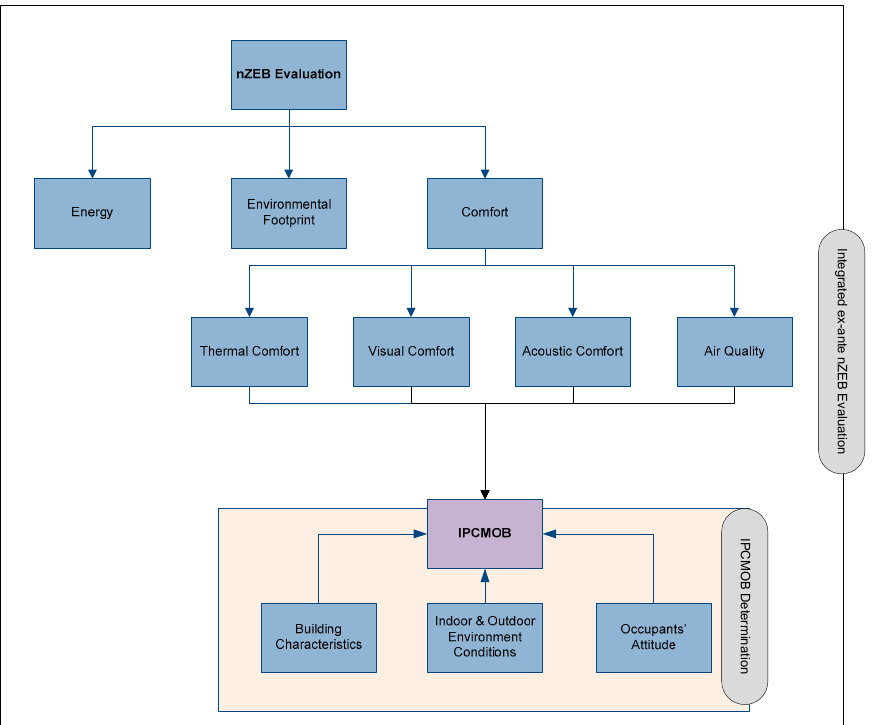
Figure 1. Presentation of methodological framework for the determination of integrated personalized comfort model in office buildings (IPCMOB). nZEB: nearly zero energy buildings.